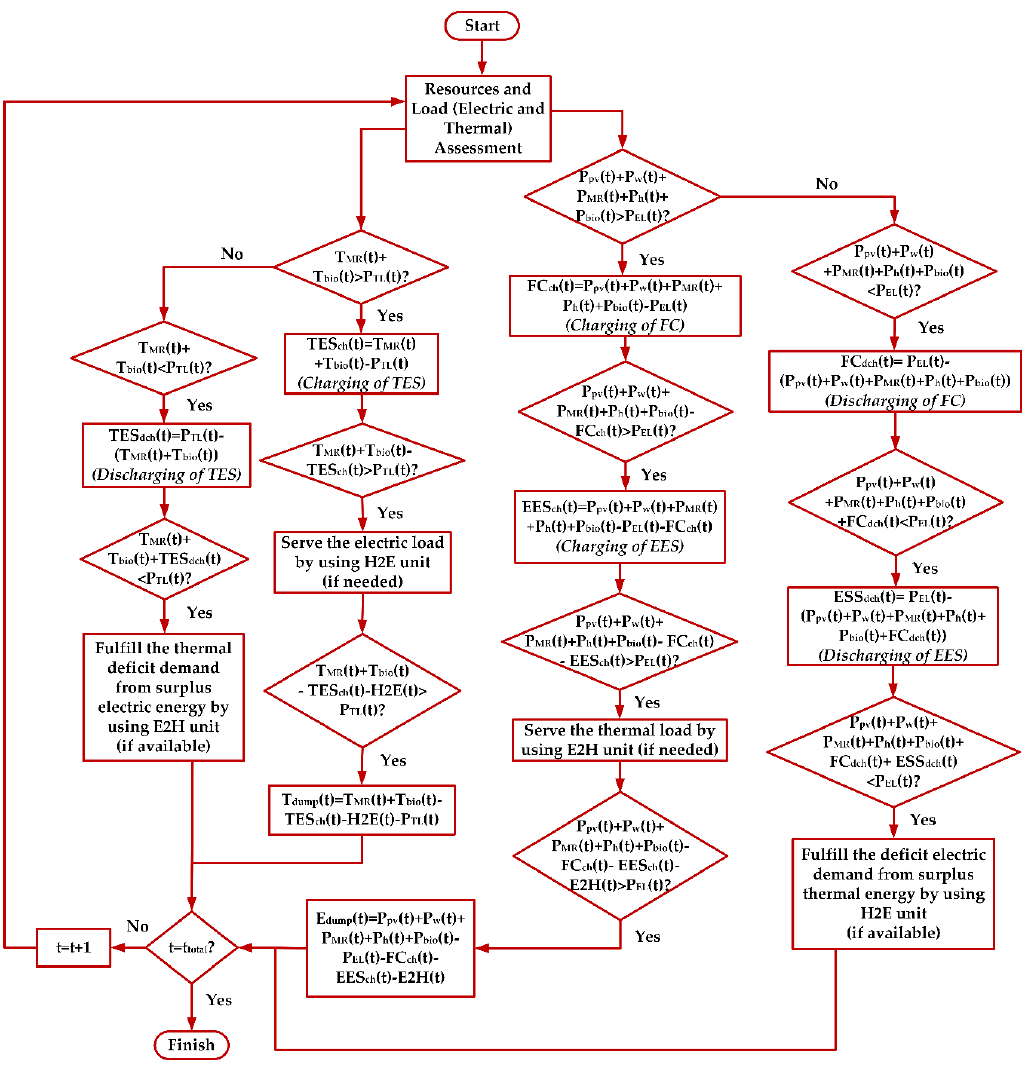
Figure 4. Energy management algorithm of MR-based MEG.